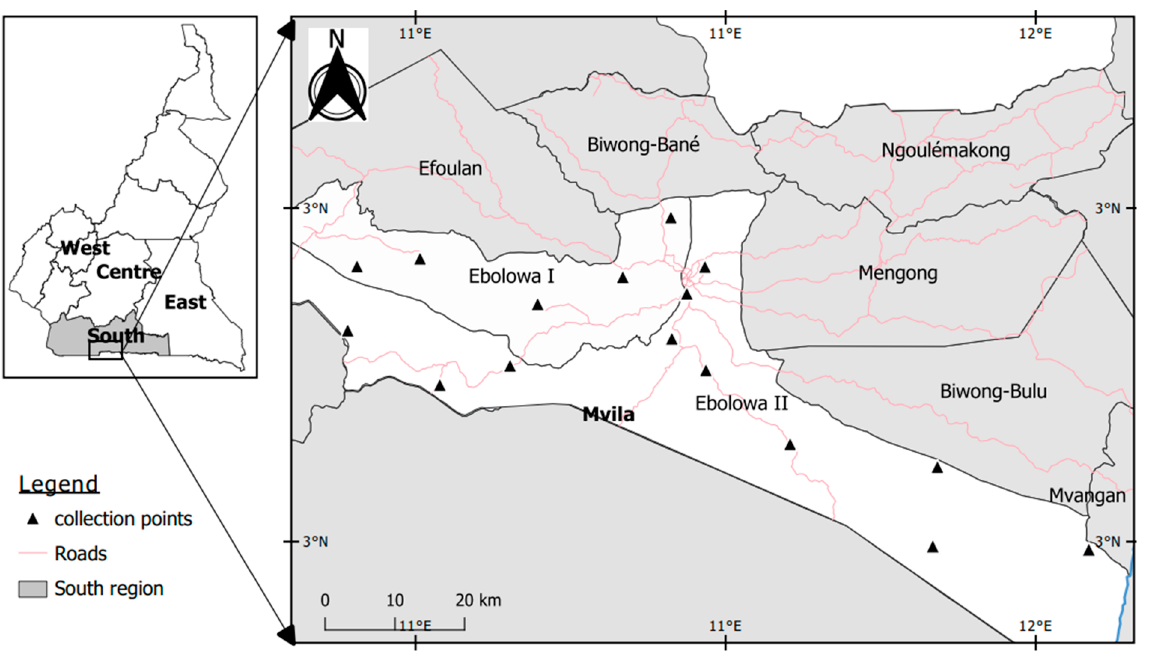
Figure 1. MAP of Cameroon showing the geographical location of EBOLOWA and distribution of larval collection